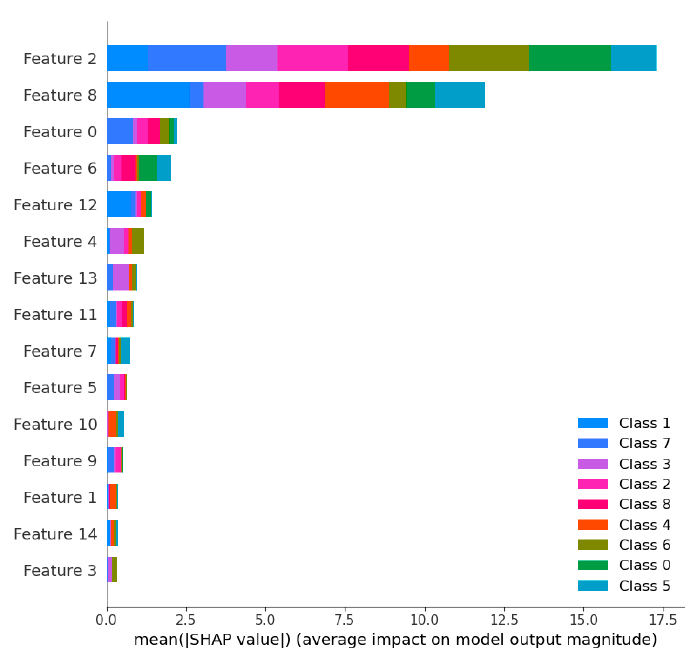
Figure 20. XGBoost algorithm filtering feature results.